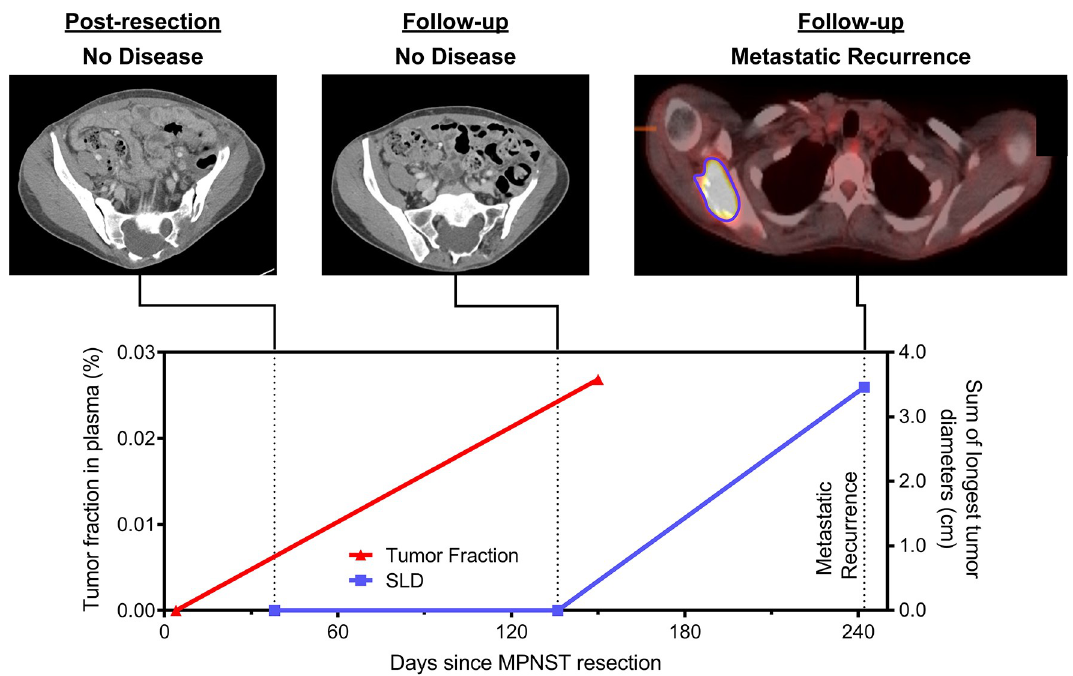
Fig 7. Early detection of relapse vignette (sar080). This patient previously had a high-grade pelvic MPNST that was completely resected with no evidence of residual disease after surgery. Tumor fraction in plasma was undetectable following resection but was detected 150 days later (tumor fraction = 0.021); this preceded metastatic recurrence identified on surveillance imaging by 89 days. cm, centimeters; MPNST, malignant peripheral nerve sheath tumor; SLD, sum of longest tumor diameters as determined by RECIST 1.1